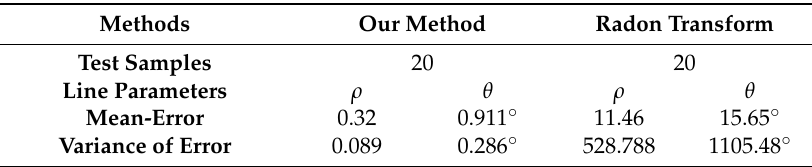
Table 3. The mean-error and variance of two